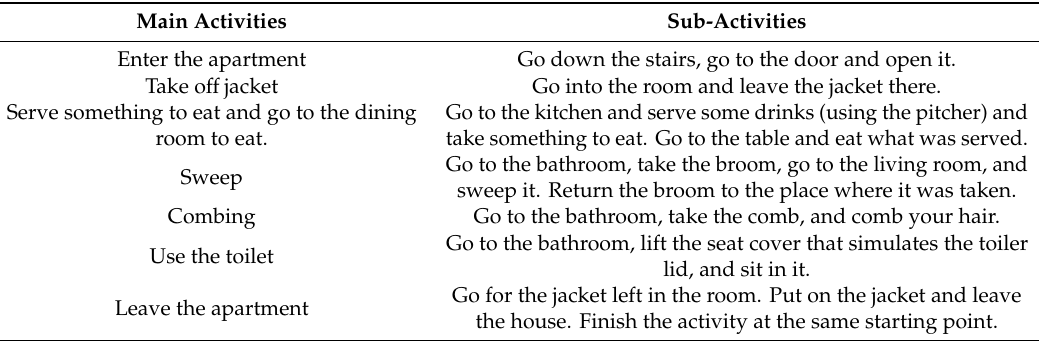
Table 2. Activities performed by the